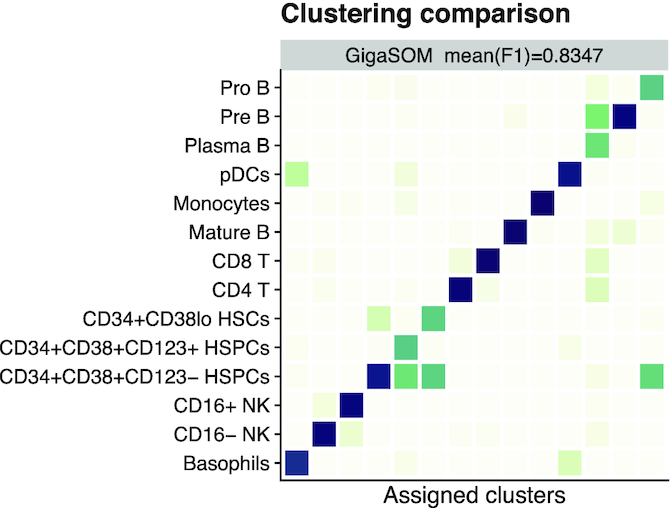
Comparison of GigaSOM.jl results with manual gating of the Levine32 dataset. The confusion matrix is normalized in rows, showing the ratio of cells in each aggregate of GigaSOM-originating clusters that matches the cell types from manual analysis. Darker color represents better match. The mean F1 score is comparable to FlowSOM. A more comprehensive comparison is available in Supplementary Fig. S1.